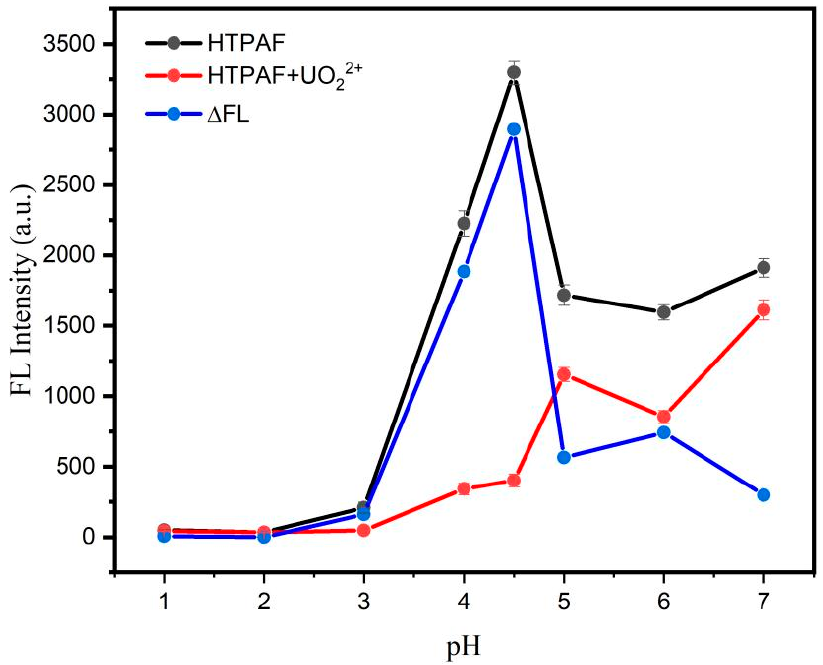
Figure 3. Fluorescence intensity of HTPAF before and after the addition of UO 22+ at different pH and the fluorescence change values (HTPAF, 50 μ M, UO 22+ , 50 μ M).